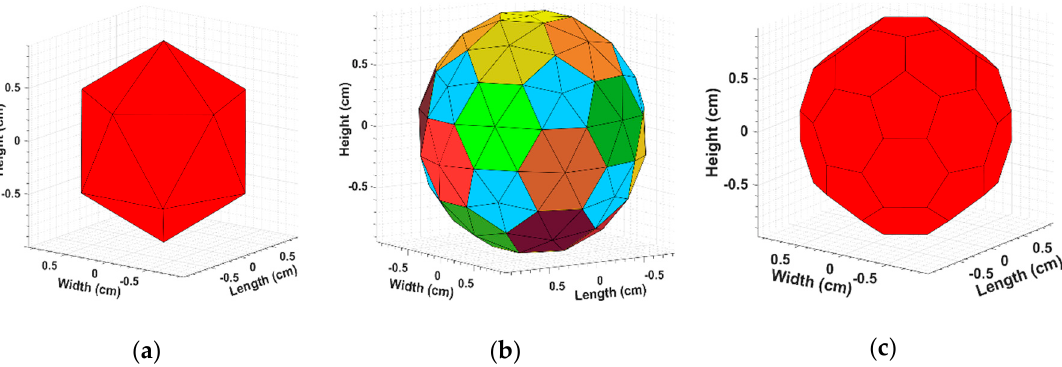
Figure 4. Transmission sphere segmentation using a geodesic grid; ( a ) an icosahedron inscribed on a circle, ( b ) subdivided icosahedron by bisecting each triangle and projecting onto the sphere generates pentagons, shown in light blue, and hexagons, and ( c ) a rotated and scaled version of the Voronoi polygon.